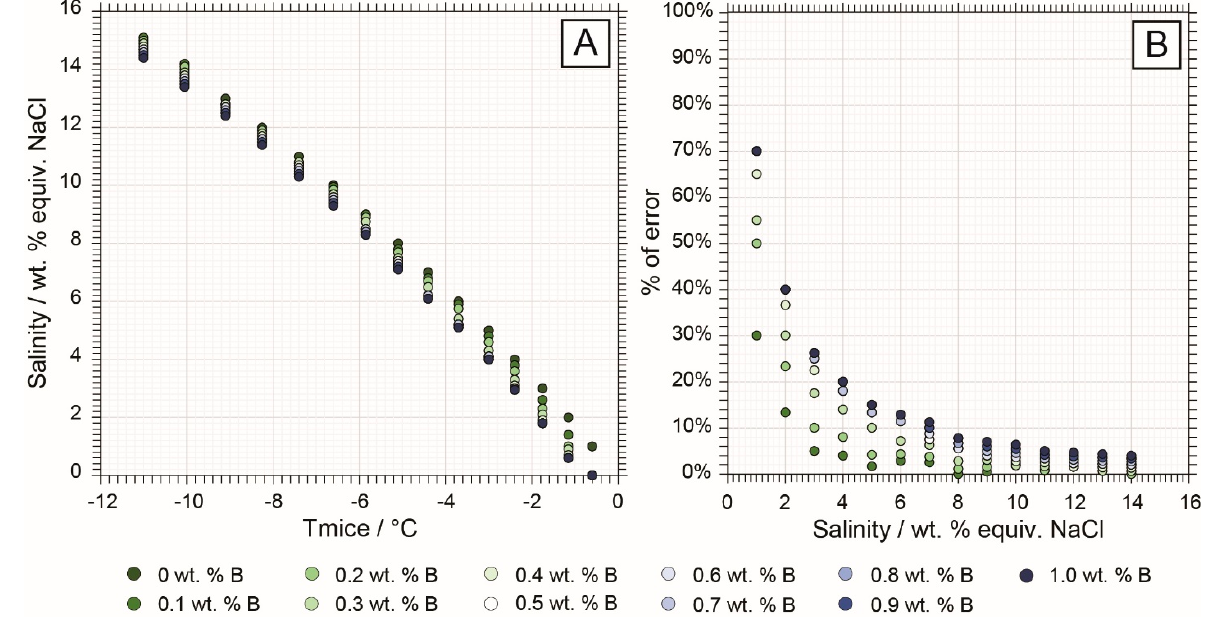
Figure 6. Salinity bias calculations comparing a H 2 O-NaCl system and increment of 0.1 wt. % of boron. The comparison is made between salinity calculations in the H 2 O-NaCl and H 2 O-NaCl-H 3 BO 3 for a range of salinity from 1 to 15 wt. % NaCl and boron concentrations between 0.1 and 1 wt. % (0.5 to 6 wt. % H 3 BO 3 ) with microthermometry measurements only [1,50]. Detailed calculations are available in Table S5. ( A ) Case of a H 2 O-NaCl-H 3 BO 3 system where T sas cannot be measured. Comparison of calculations bias at various salinity concentrations with increasing boron content using Tm ice measurement only. ( B ) Error % made in the salinity calculation in a boron-rich system if boron concentration is not considered (calculation in the H 2 O-NaCl system).